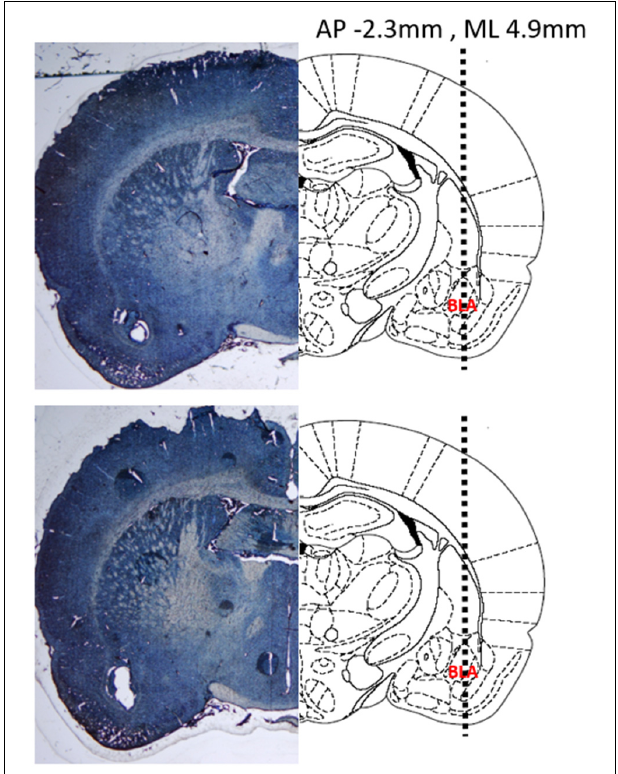
FIGURE 2 | Representative coronal sections demonstrating the location of the recording electrode in two different rat brains. (Left) Thionine stained brain slices showing a lesion at the recording site in the basolateral amygdala (BLA). (Right) Atlas diagrams with the BLA labeled and a dashed line showing the insertion trajectory of the recording electrode. Coordinates provided are relative to Bregma. Diagram adapted from Paxinos and Watson